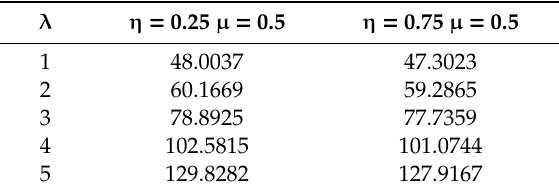
First five natural frequencies for the UD distribution for two di ff erent states of partial agglomeration.